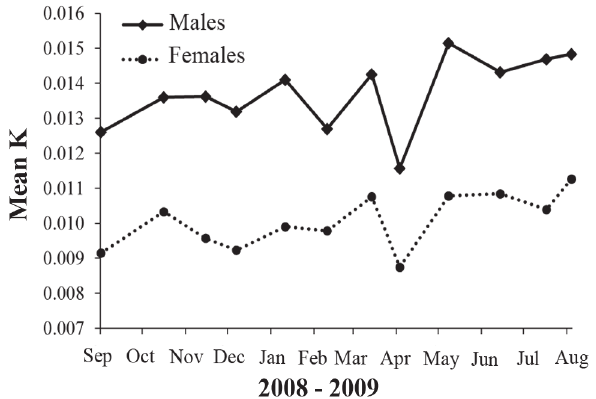
Fig. 6. Monthly variation in the allometric condition factor in male and female Anableps anableps collected at the mouth of the Maracanã River, Pará State.